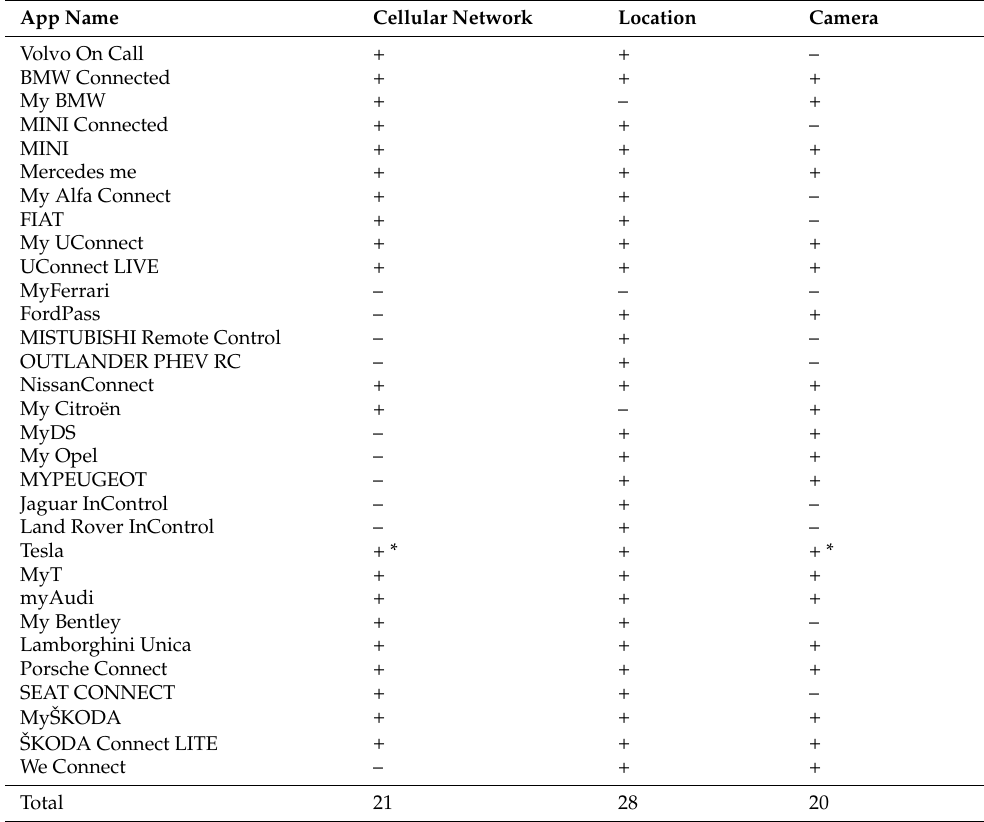
Table 4. Potentially privacy-invasive API call groups per app. The asterisk indicates that at least one API call does not coincide with the permissions requested by this